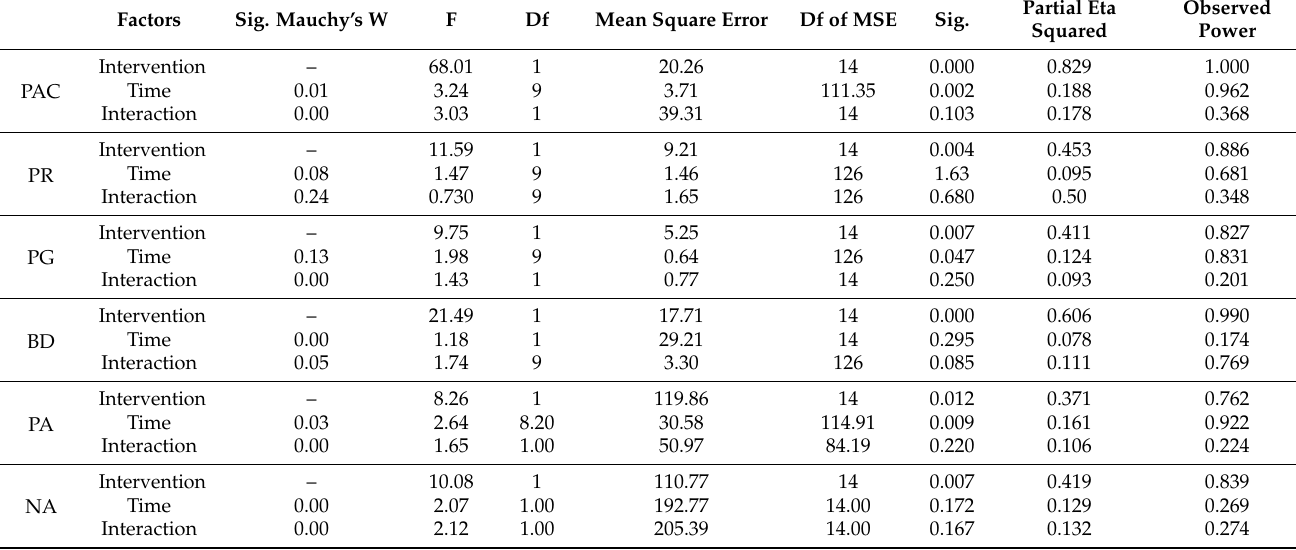
Table 2. Two-way repeated measures ANOVA of COPE and PANAS variables.